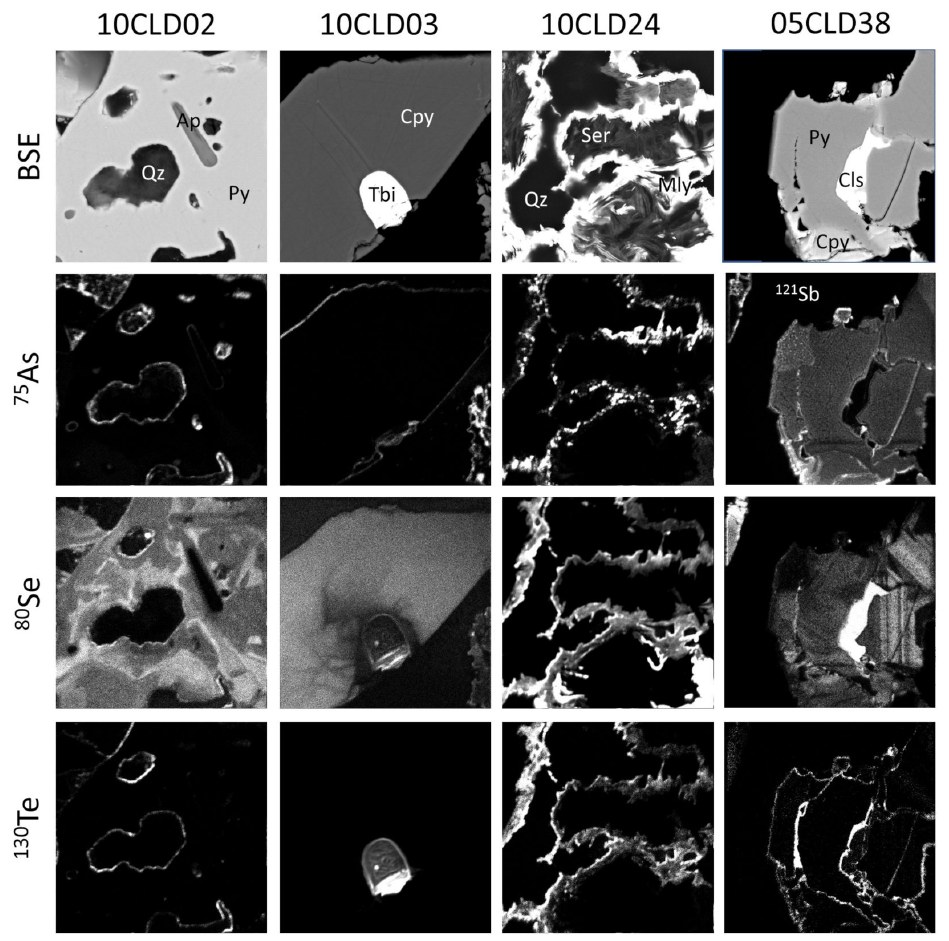
Figure 9. The BSE (top row) and nanoSIMS images of potentially deleterious elements ( 75 As, 80 Se, 121 Sb, and 130 Te) in di ff erent assemblages from the four sulfide concentrate leach discharge (CLD) samples. Abbreviations: Ap-apatite; Cls-clausthalite; Cpy-chalcopyrite; Mly-molybdenite; Py-pyrite; Qz-quartz; Ser-sericite; Tbi-tellurobismuthite. Note that 121 Sb was analyzed instead of 75 As for sample 05CLD38. Previously undetected zoning may be seen with respect to Se in samples 10CLD02, 10CLD03, and